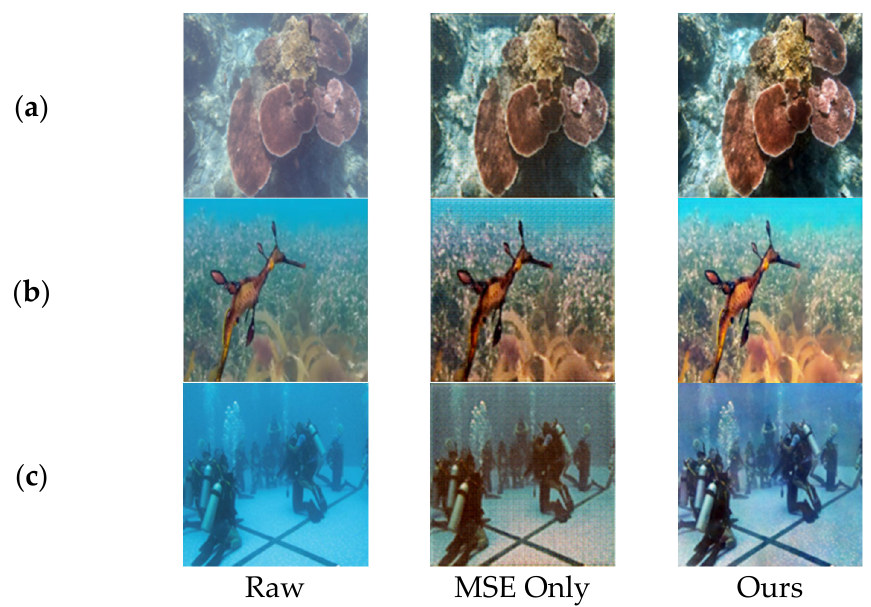
Figure 5. Subjective comparisons on real-world underwater images. From left to right are raw underwater images, the results of using MSE loss function only and using our proposed loss function.